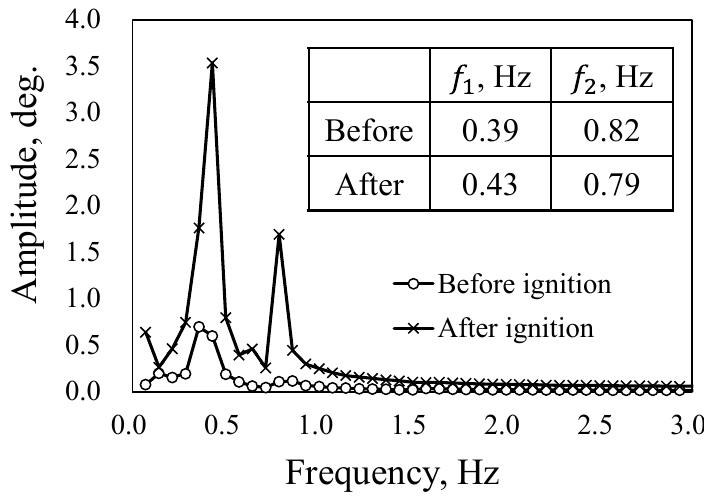
Figure 5. Spectrum of elevation angle before and after ignition.